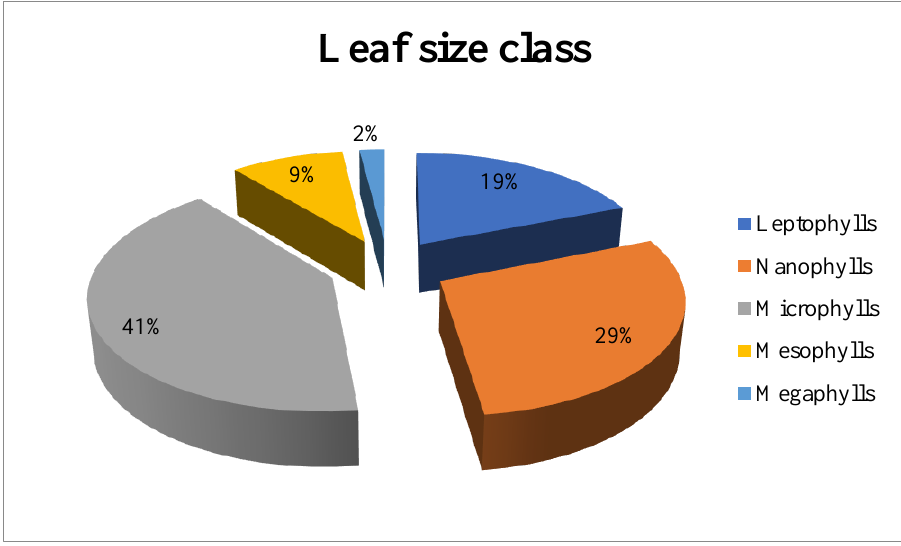
Figure 3. Leaf size classes of the plant species recorded in the understory vegetation of oak-dominated forests of Swat, Pakistan.